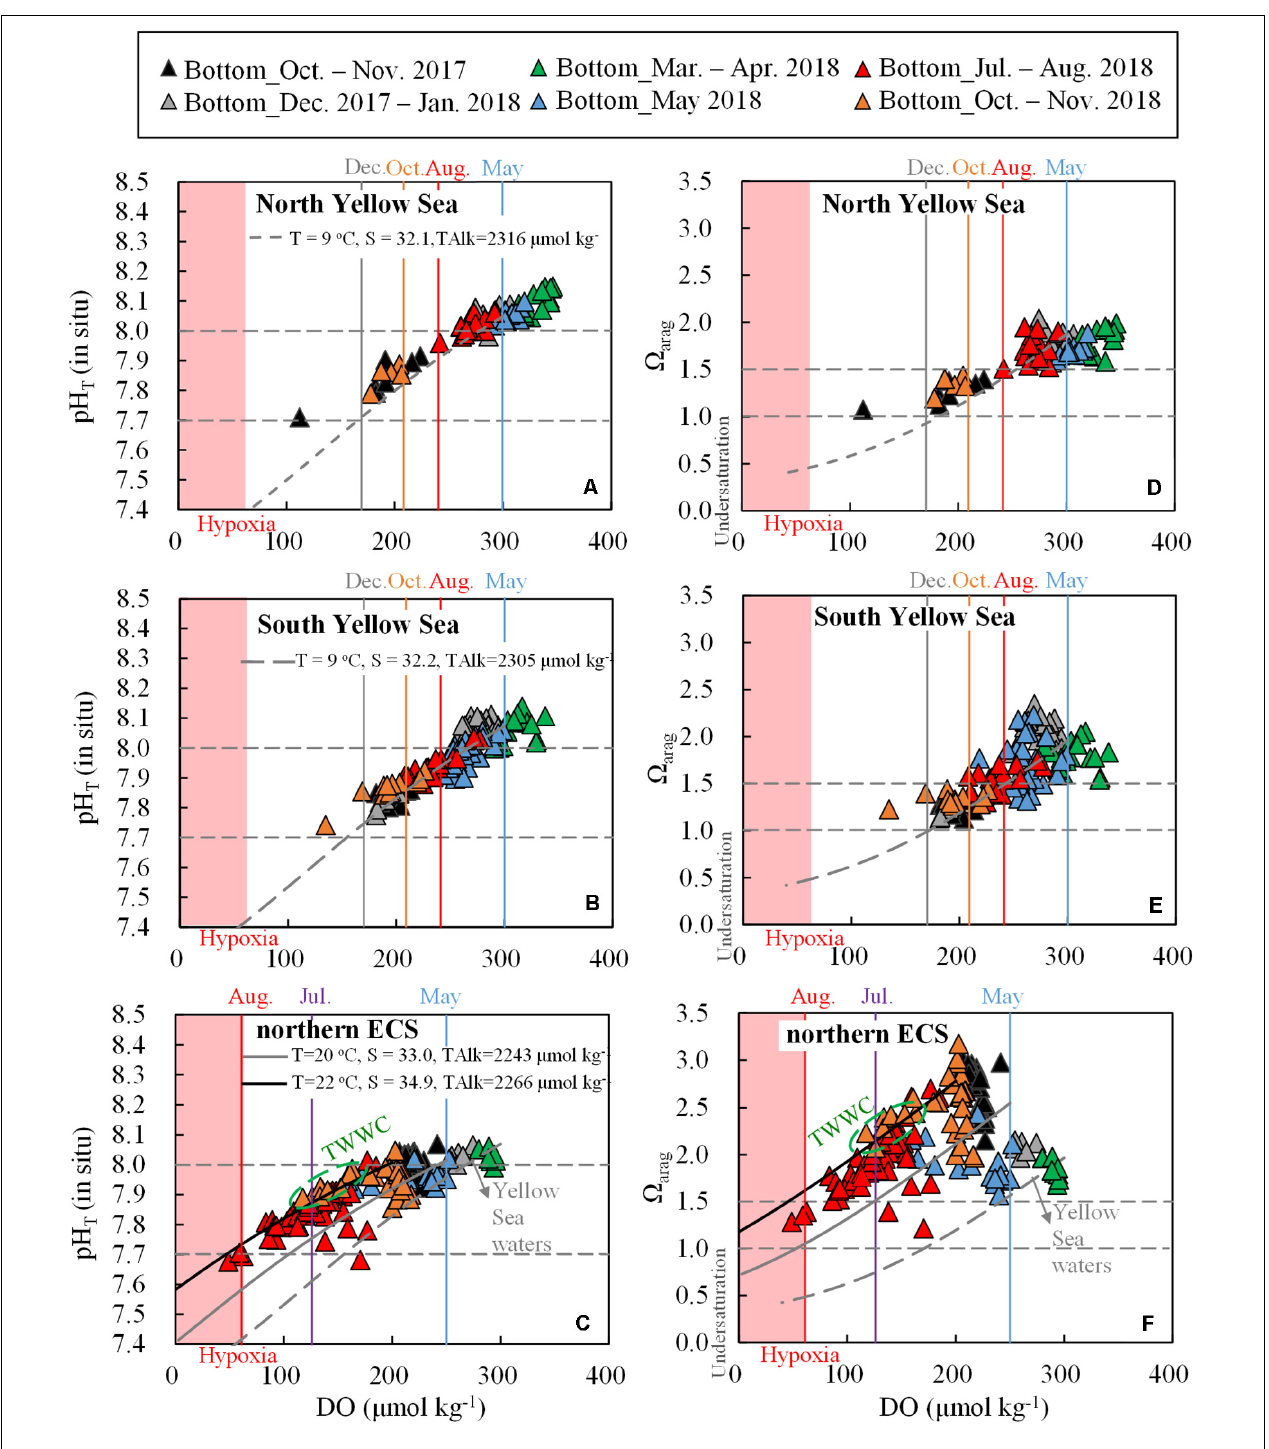
FIGURE 7 | (A–C) Bottom-water pH T ( in situ ) versus DO and (D–F) (cid:127) arag versus DO. Shaded pink areas represent hypoxia (DO < 63 µ mol O 2 kg - 1 ). Data points in the Yellow Sea during summer to autumn are within the YSCWM. Black and gray curves represent respiration-induced pH T and (cid:127) arag changes, based on the Redfield equation and the corresponding net DO consumption rates in the Yellow Sea (0.6 µ mol O 2 kg - 1 d - 1 ) and northern ECS (2 µ mol O 2 kg - 1 d - 1 ). During calculation, starting conditions for the North Yellow Sea were DO = 300 µ mol kg - 1 , DIC:TAlk ratio = 0.930; starting conditions for the South Yellow Sea were DO = 300 µ mol kg - 1 , DIC:TAlk ratio = 0.925; starting conditions for the northern ECS were DO = 250 µ mol kg - 1 , DIC:TAlk ratio = 0.900, while for the ECS offshore waters (affected by the TWWC) were DO = 200 µ mol kg - 1 , DIC:TAlk ratio = 0.890. The impact of respiration on TAlk ( (cid:49) TAlk: (cid:49) DIC = –17/106) was also included.